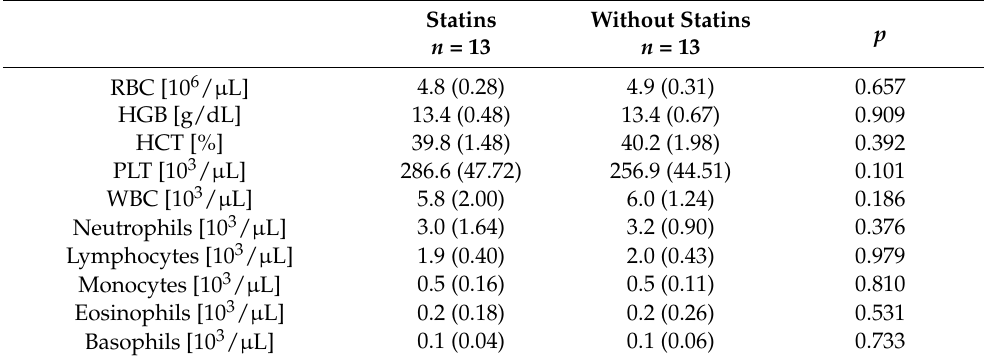
Table 2. Blood count and differential count of major leukocyte groups in children with familial hypercholesterolemia treated with a combination of statins and a low-cholesterol diet, and those on an exclusive low-cholesterol diet for 6 months. The data are shown as mean values and standard deviation (in brackets). A Mann–Whitney two-sided rank U-test was used.